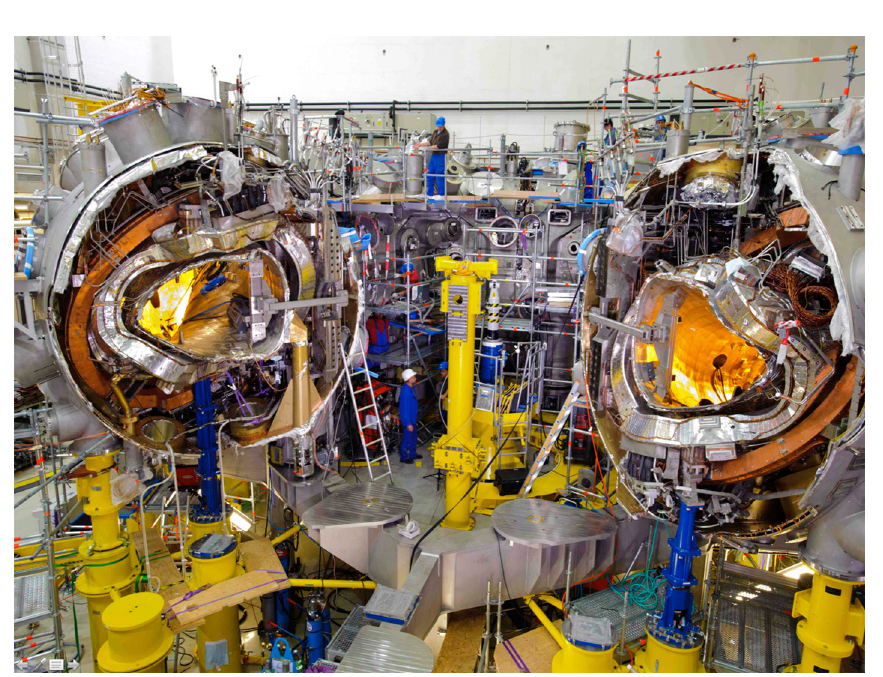
Fig. 10. – A picture of the stellarator Wendelstein 7-X, at the time of construction in November